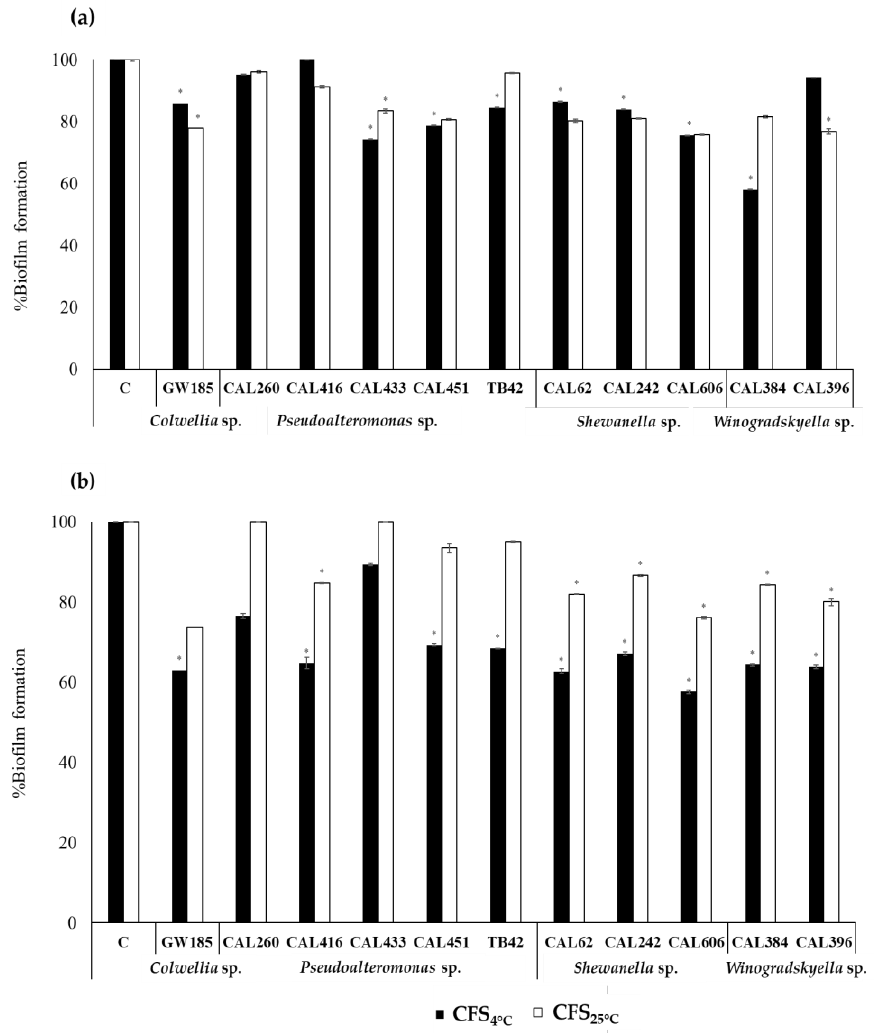
Figure 1. Biofilm formation (%) of P. aeruginosa ATCC 27853 ( a ) and S. aureus ATCC 29213 ( b ) after 48 h and 24 h treatment, respectively, in absence (Control, C) or in presence of CFSs from Antarctic sponges-associated bacteria obtained after incubation at 4 (CFS 4°C black bars) or 25 °C (CFS 25°C , white bars). The data were analyzed by One-way ANOVA. Statistically significant differences ( p ≤ 0.05) between the control (C) and treated samples are indicated by an asterisk (*). Refer to Table 1 for bacterial strain affiliation.